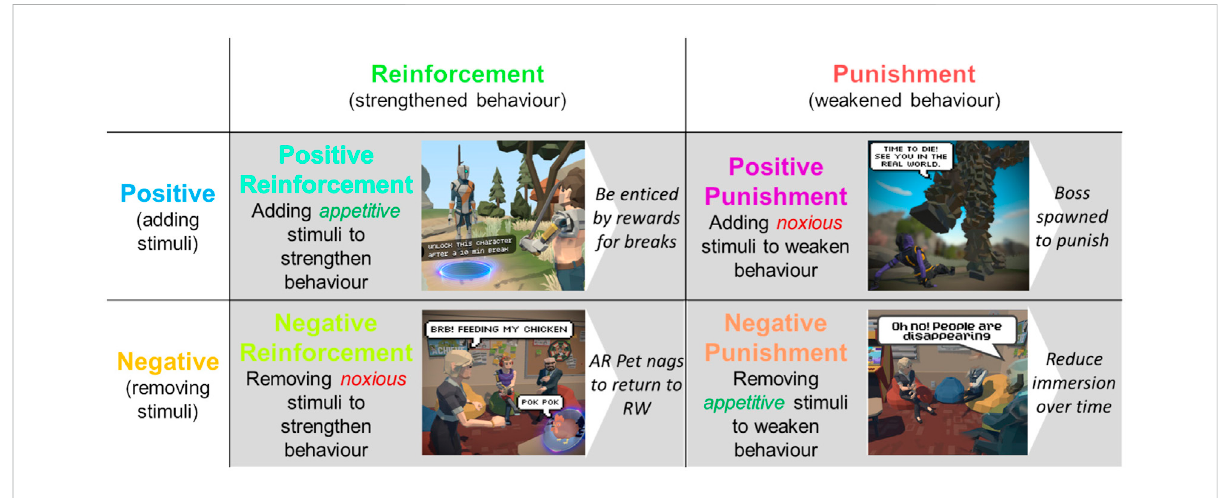
FIGURE 13 Four quadrants of operant conditioning with examples of disengagement